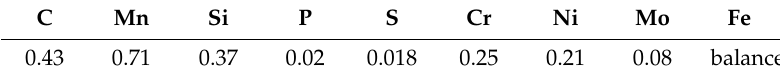
Table 1. Chemical composition of steel used [wt. %].